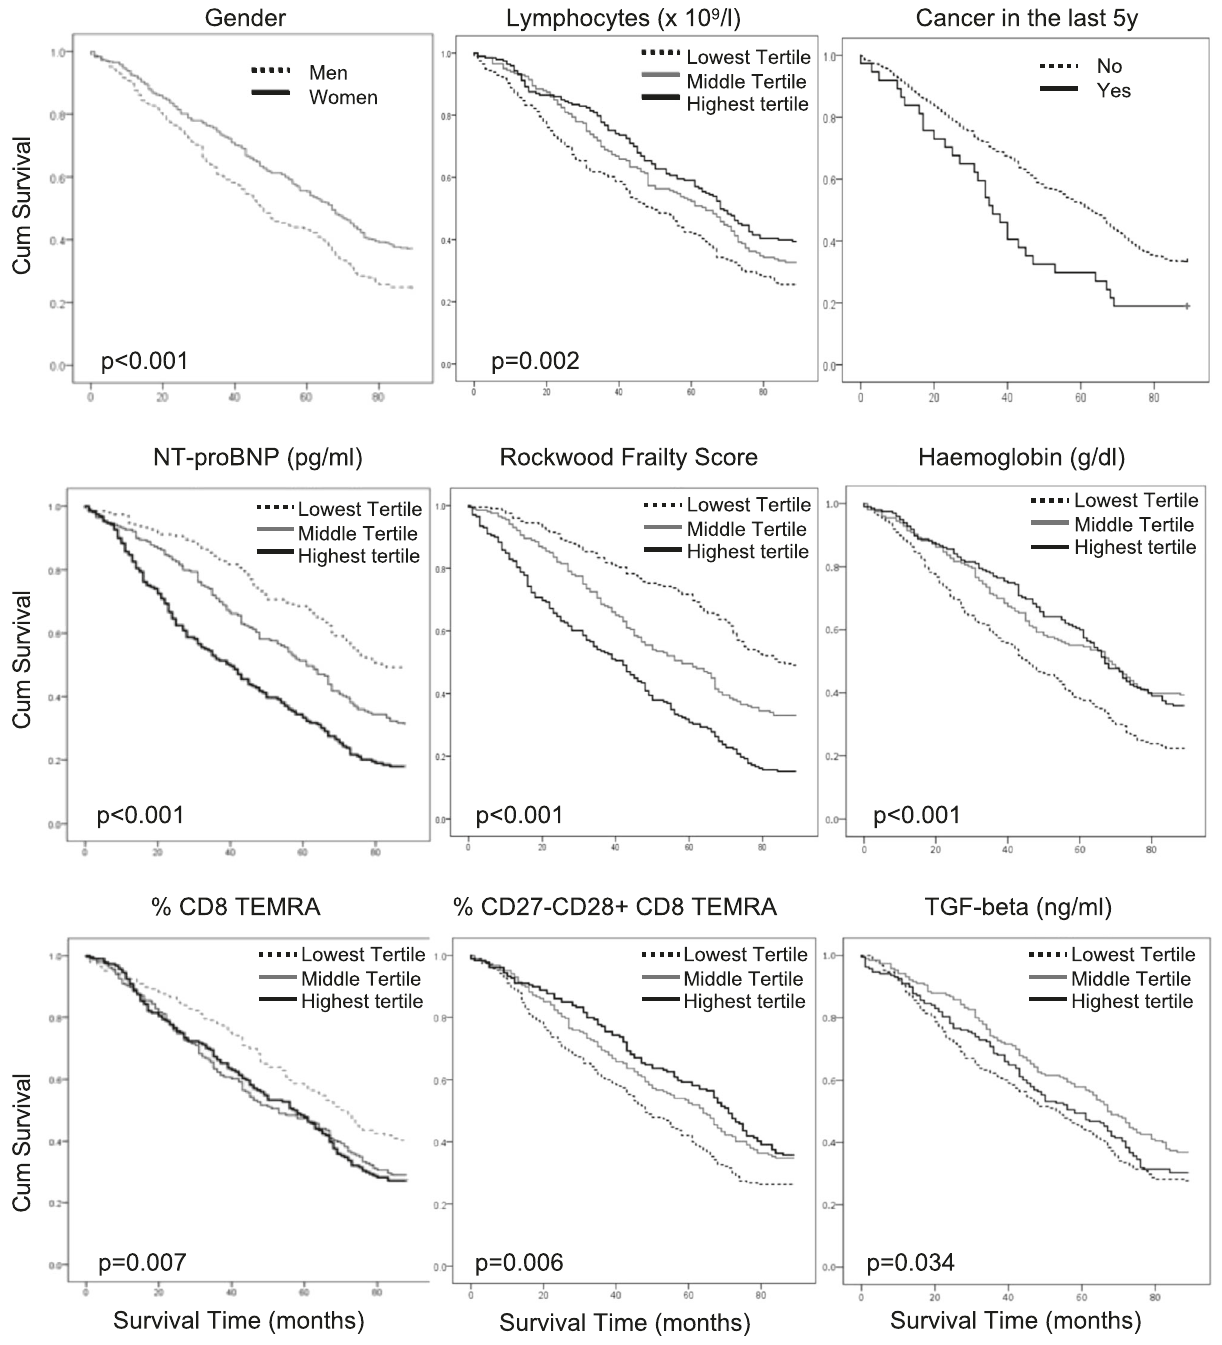
Fig. 1 Gender, comorbidity and lymphocytes predict survival in the Newcastle 85 + study. Kaplan-Meier curves with their respective log- rank p-values identify male gender and pre-existing comorbidity, such as cancer, frailty, anaemia or heart failure (re fl ected by elevated plasma NT-proBNP) as predictors of adverse outcome in octogenarians. Likewise, low lymphocyte counts (tertiles <1420 × 10 6 / μ l, 1420 – 1940 × 10 6 / μ l and >1940 × 10 6 / μ l) and a low percentage of CD27 − CD28 + CD8 + T EMRA cells (tertiles <1.9%, 1.9 – 3.4% and >3.4%) are singular predictors of reduced